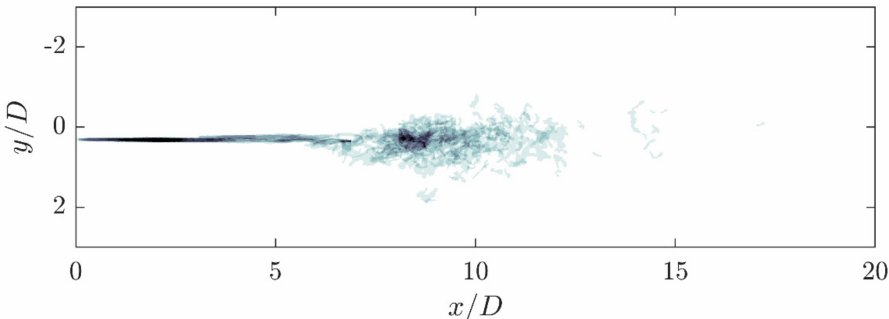
Figure 21. Superposition in the wake area of the orifice in the test facility scaled to scale 5 of the droplets injected away from the axis of symmetry, closer to the edge of the orifice (r ∗ = 0.75) in front of the orifice at Re =